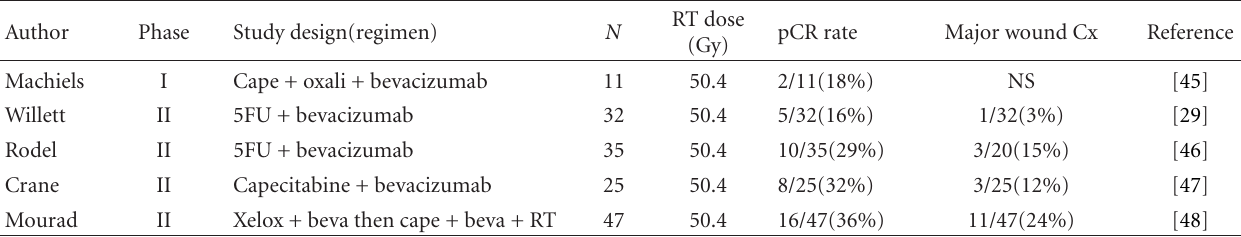
Table 3: Clinical trials of bevacizumab in preoperative treatment of rectal cancer.